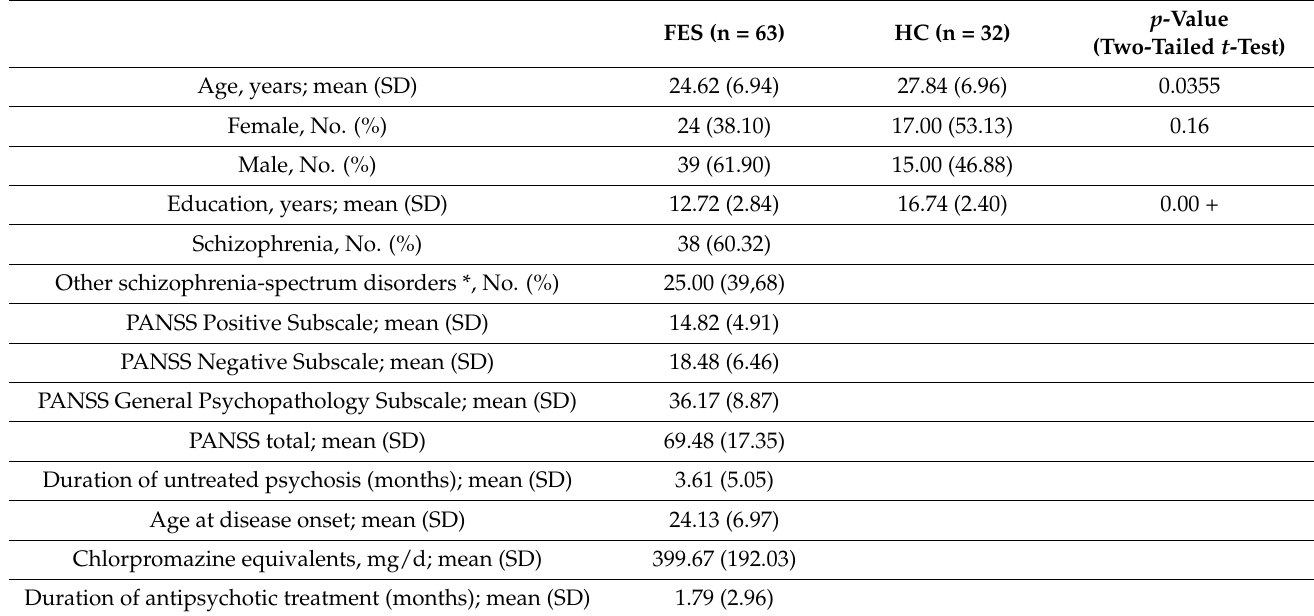
Table 1. Sociodemographic and clinical Data for the first-episode schizophrenia-spectrum and healthy control groups.